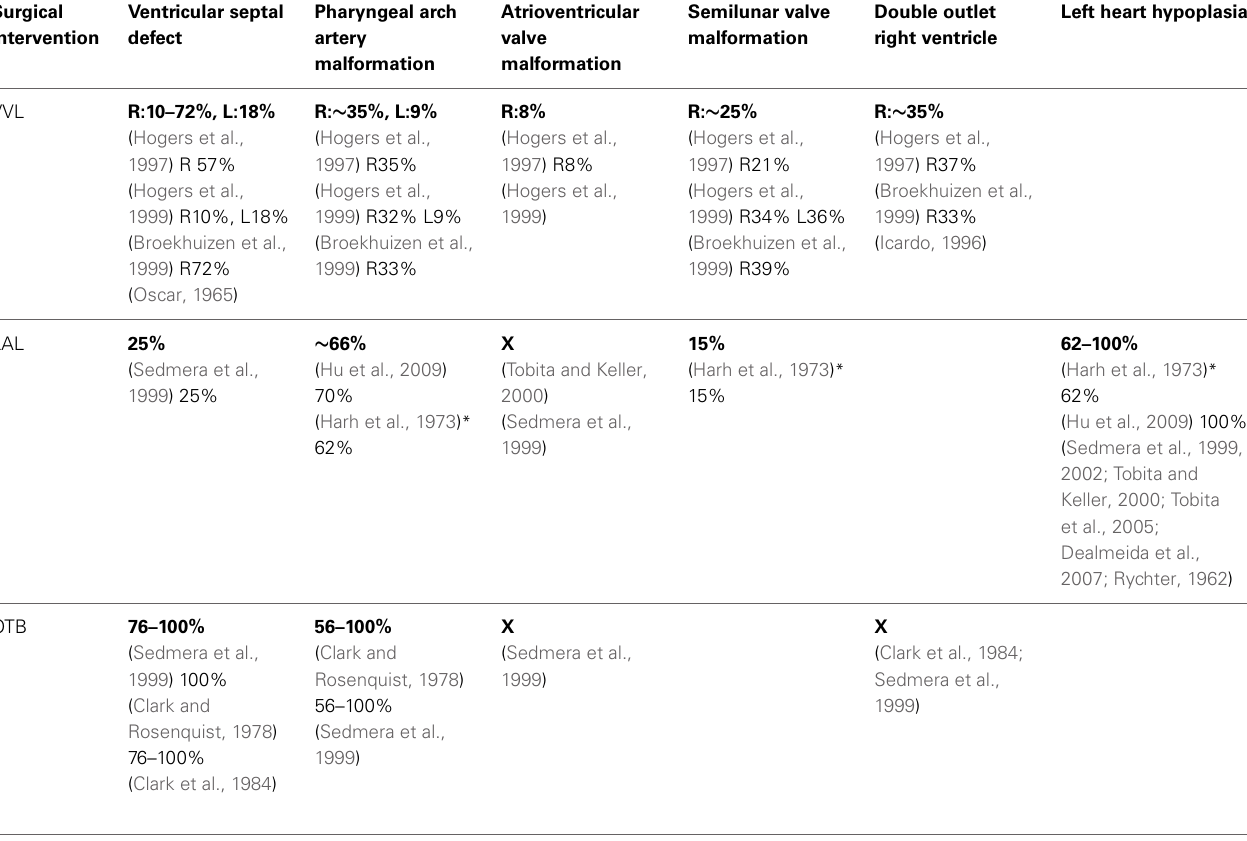
Table 3 | Summary of reported cardiac defects after surgical intervention. Surgical Ventricular septal intervention defect